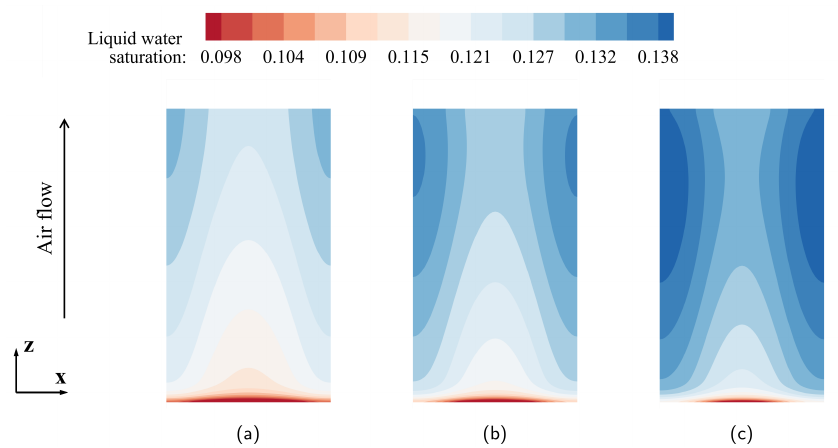
Figure 14. Impact of the LCWR on the liquid water saturation over the middle plane of the CCL: